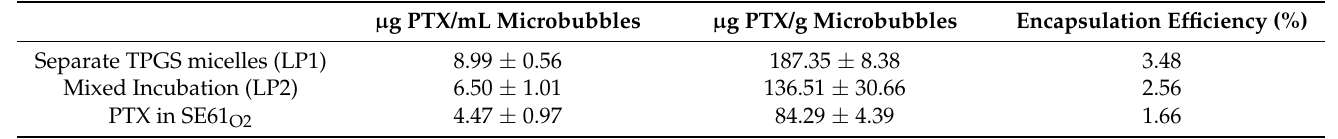
Table 5. Effect of method of dual drug incorporation on PTX